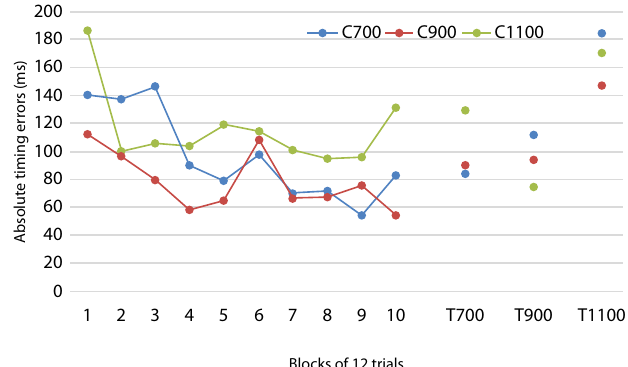
Figure 8 . Absolute timing errors ( A E) in acquisition (blocks 1-10), Constant 700 ms test (T700), Constant 900 ms test (T900) and Con- stant 1.100 ms test (T1100).